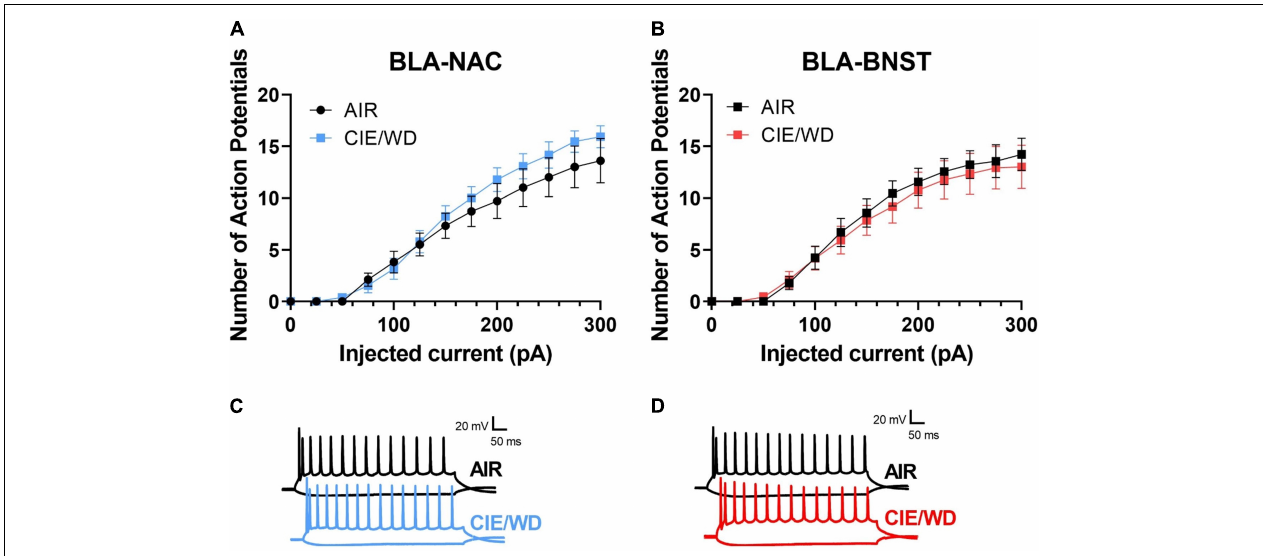
FIGURE 4 | CIE/WD did not alter intrinsic excitability in male BLA neurons in the absence of synaptic transmission. (A) CIE/WD did not affect intrinsic excitability in male BLA-NAC neurons ( n = 10 AIR, 13 CIE/WD). (B) CIE/WD did not affect intrinsic excitability in male BLA-BNST neurons ( n = 9 AIR, 12 CIE/WD). (C) Exemplar traces of 600-ms current steps of –100 and + 300 pA in BLA-NAC AIR (top) and CIE/WD (bottom) neurons. (D) Exemplar traces of 600-ms current steps of –100 and + 300 pA in BLA-BNST AIR (top) and CIE/WD (bottom) neurons. Data analyzed by two-way ANOVAs.